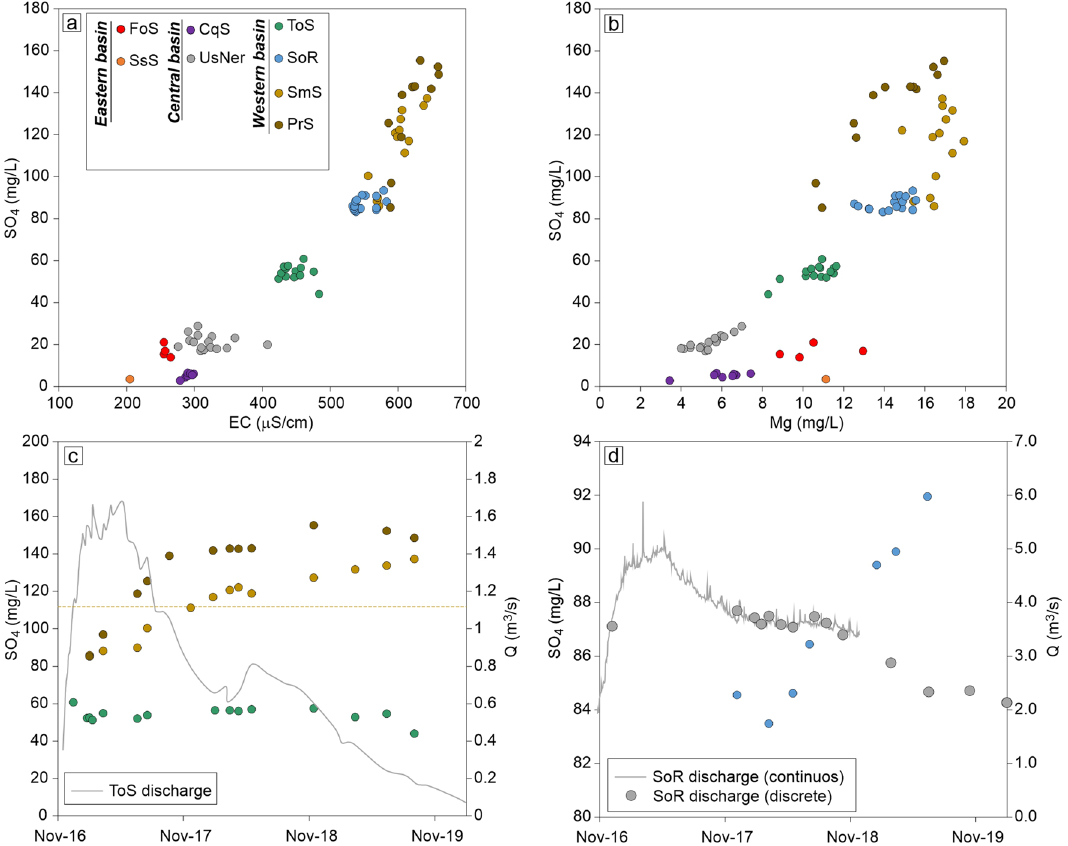
Figure 3. Geochemical features of sampled waters. ( a ) Electrical conductivity vs. SO 4 concentration. ( b ) SO 4 vs. Mg concentration. ( c ) Time variation of SO 4 concentration of ToS, SmS and PrS compared with ToS discharges (grey line). The average SO 4 concentration of SmS (January–February 2016) is also reported (dashed pale brown line). Symbols in all panels: Foce Spring (FoS, red dots), Sassospaccato Spring (SsS, orange dots), Capodacqua Spring (CqS, purple dots), Ussita-Nera River system (UsNeR grey dots), San Martino Spring (SmS, pale brown dots), Pratarella Spring (PrS, brown dots) Torbidone Spring (ToS, green dots) and Sordo River system (SoR, blue dots). UsNeR includes data from both springs and river waters upstream of UsNeR; SoR includes data from different location along Sordo river (Fig.